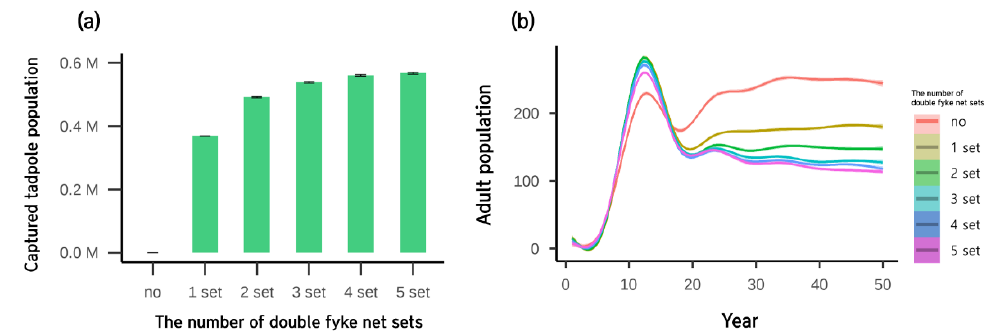
Figure 5. ( a ) The effect of the number of double fyke net sets on captured tadpoles during the simulation period and ( b ) adult population. Results show the mean and SE with 30 replicates.